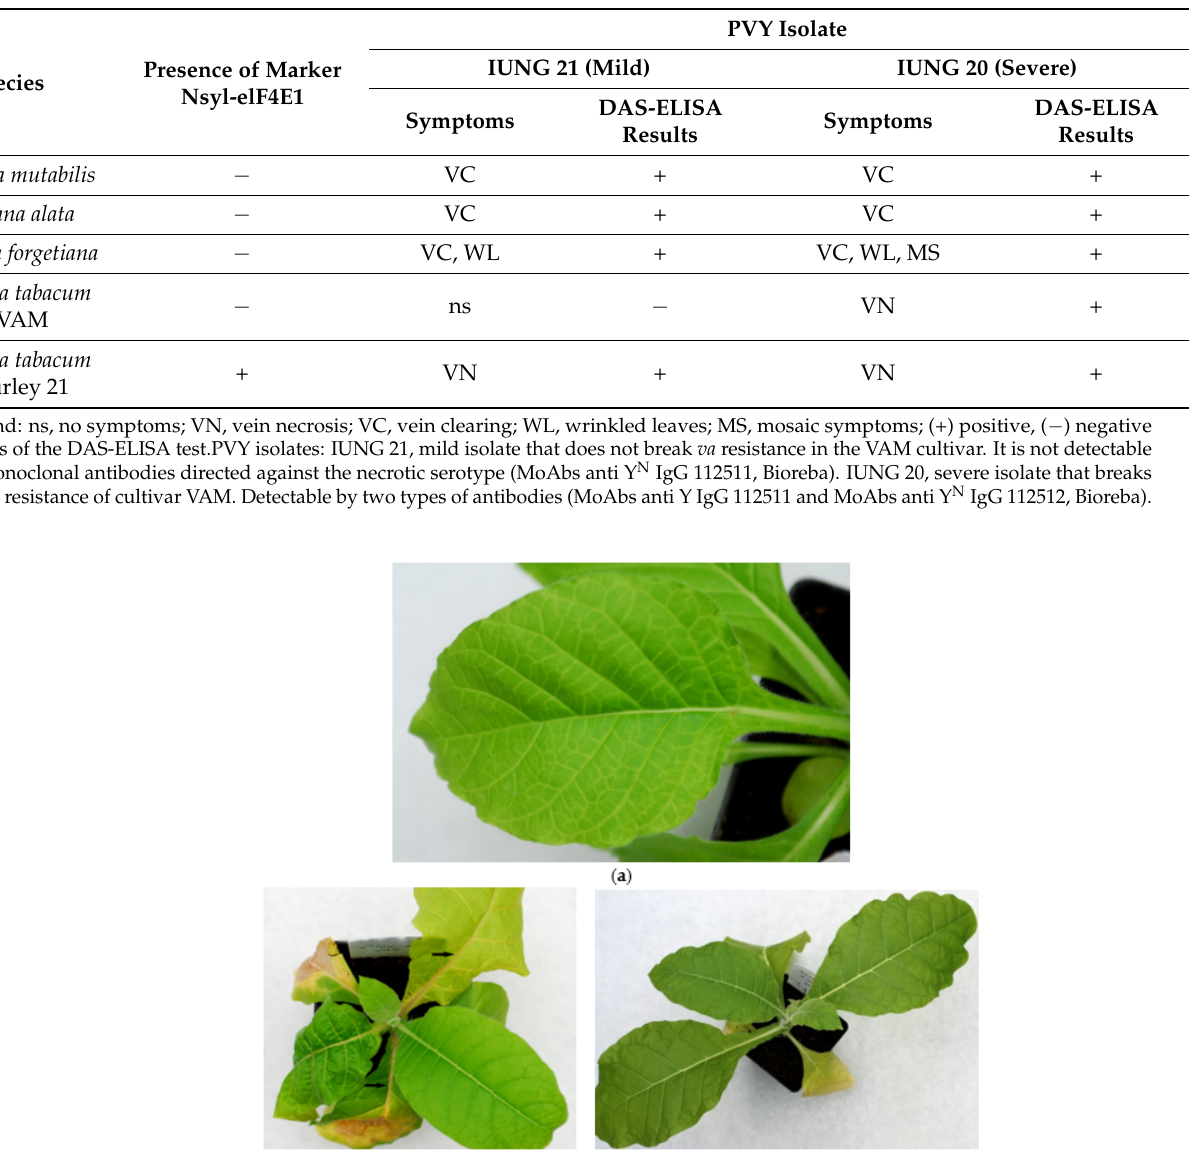
Table 2. Presence of the Nsyl-elF4E1 marker characteristic for the Va gene responsible for susceptibility and the reaction of the tested species after inoculation with two PVY isolates.